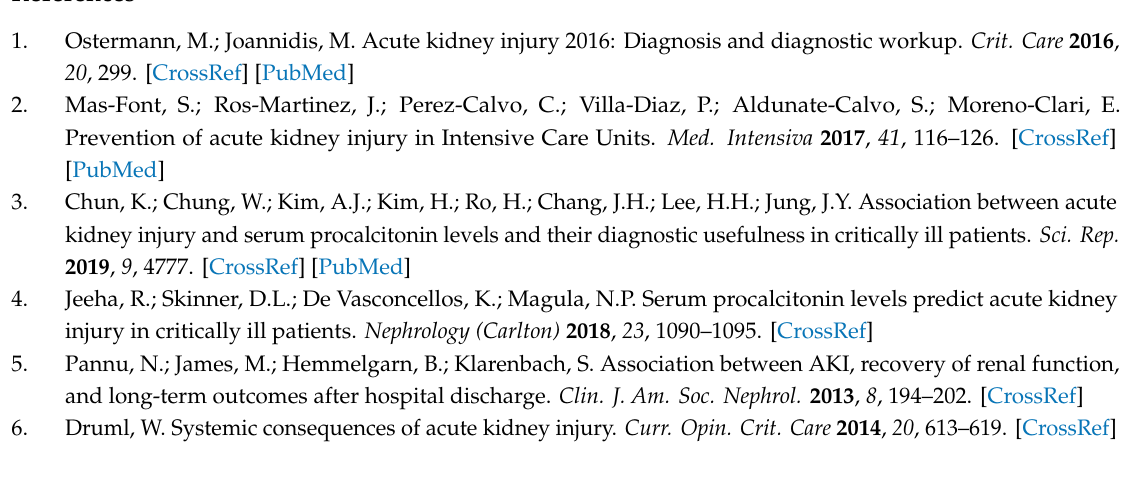
Figure S1. Comparisons of PCT levels between two groups stratified by infection in plots with (A) serum creatinine ratio and (B) eGFR as X-axis. Abbreviations: eGFR = estimated glomerular filtration rate; PCT = procalcitonin, Figure S2. Median levels of serum PCT among four groups stratified by AKI and infection. Note: Data were expressed as median (range). *** and ### denote p < 0.001 in the comparisons of serum PCT between AKI ( + ) and AKI ( − ) groups and between infection ( + ) and infection ( − ) groups, respectively. Th statistical analyses were made using independent t-test. Abbreviations: AKI = acute kidney injury; PCT = procalcitonin. Table S1. Comparisons of PCT levels among patients with di ff erent AKI stages and infection states. Note: Th data were presented as “PCT levels (95% confidence interval)”. Th PCT levels were transformed back from the log form which had been used for analyses. Th analysis of covariance was performed using mixed linear models with log-transformed PCT as the measure of interest (dependent variable), AKI states and infection as fixed factors, and baseline estimated glomerular filtration rate and sequential organ failure assessment score as covariates. 1 denotes overall comparisons among AKI stages. 2 denotes overall comparisons between infection group and non-infection group. Abbreviations: AKI = acute kidney injury, PCT =